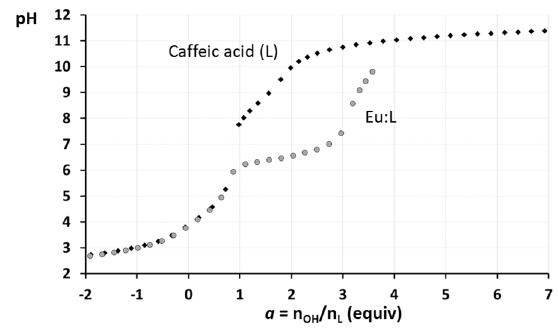
Figure 5. Representative potentiometric titration curves of CFA in the absence and presence of Eu 3+ ions at 1:1 metal-to-ligand ratio (negative abscissae refers to the titration of strong acid added to the solutions to lower starting pH).